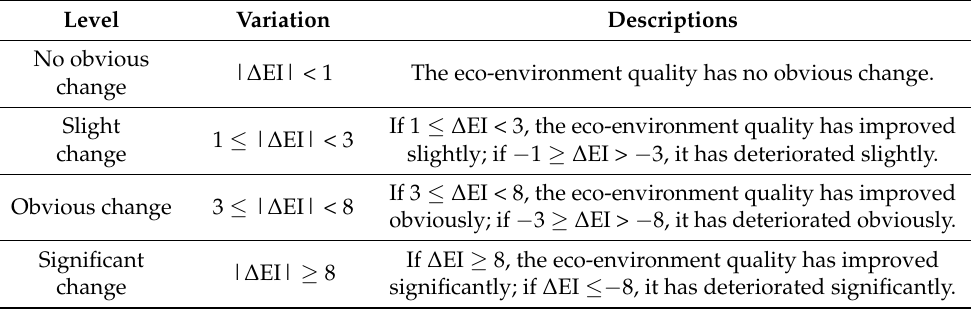
Table 4. Grading of the change degree of the eco-environmental